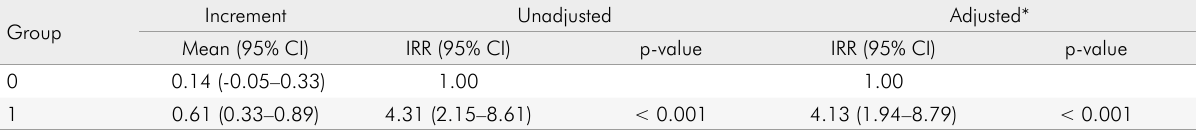
Table 3. Increment of caries activity over the study period and its association with independent variables. Unadjusted and adjusted Poisson regression models